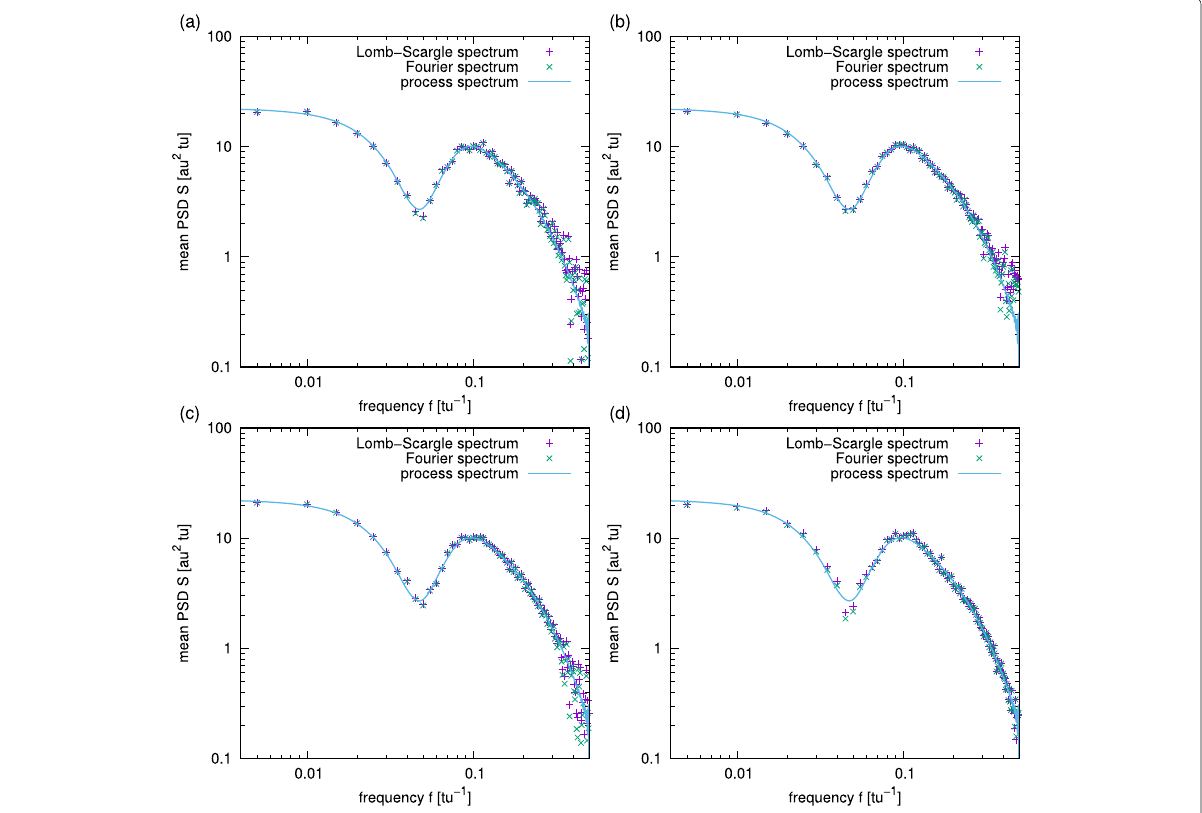
Fig. 6 Mean of the power spectral density with empirical correction factors from 1000 signals. a Ideal random and independent samples from continuous time with a continuous distribution of sampling intervals, b random samples from continuous time with a continuous distribution of sampling intervals with processor dead time, c independent outliers in equidistant time with a discrete distribution of sampling intervals, and d correlated data gaps in equidistant time with a discrete distribution of sampling intervals (au, amplitude unit; tu, time